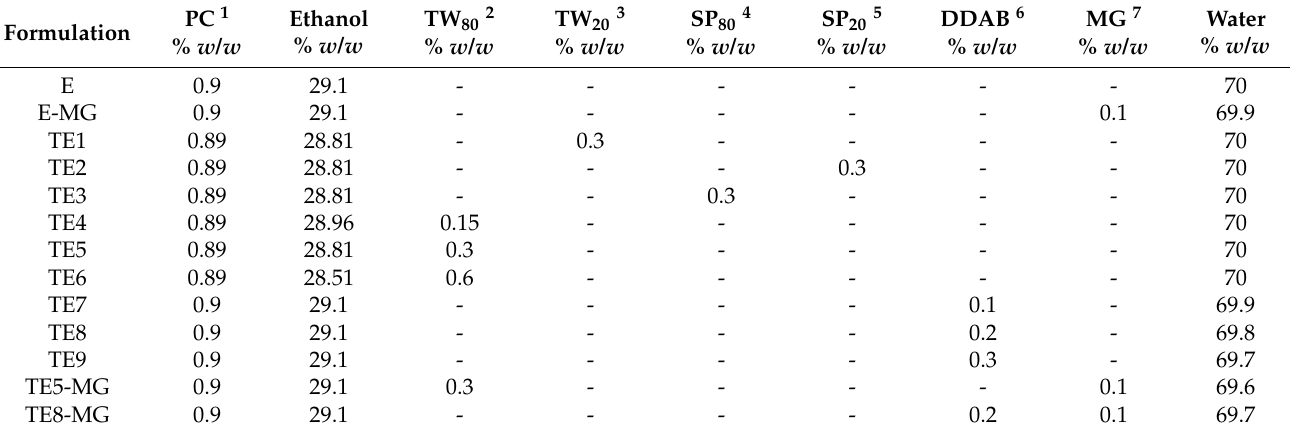
Table 2. Composition of ethosomes and